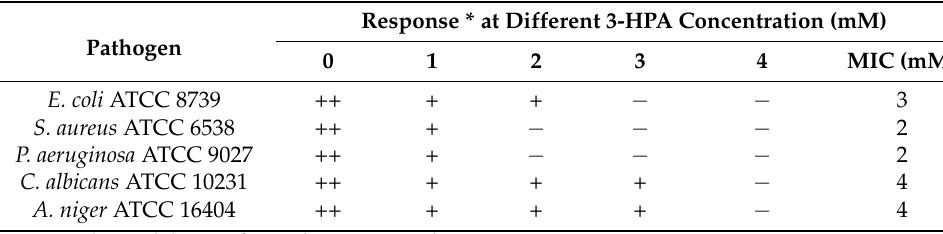
Table 2. The Effect of 3-hydroxypropionaldehyde concentration on antibiotic activity. Response * at Different 3-HPA Concentration (mM) Pathogen